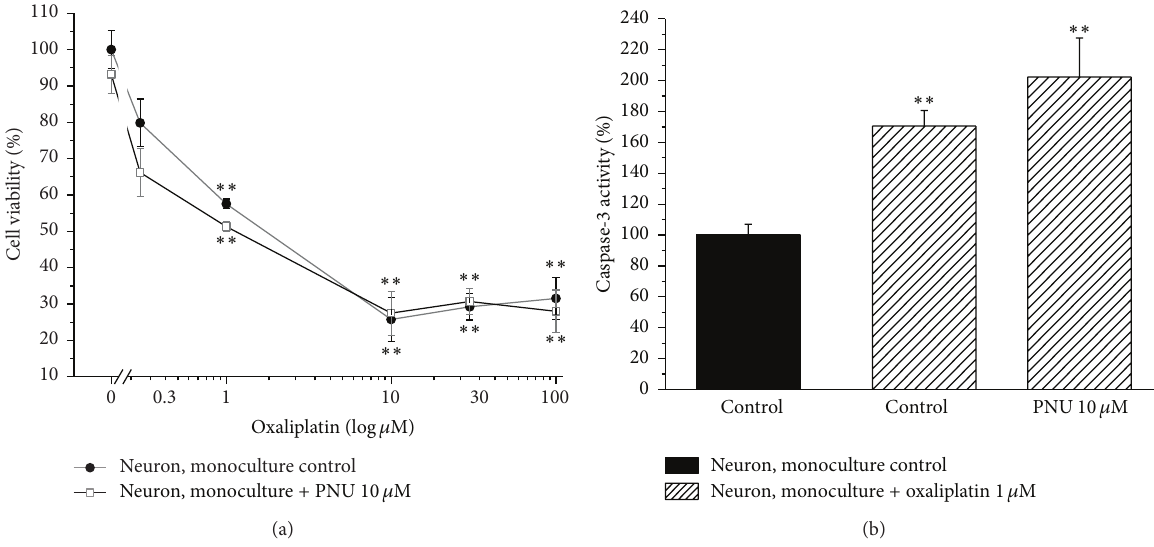
Figure 3: Effect of PNU in neuron monoculture. (a) Cell viability. Neurons (10 4 cells/well) were incubated with oxaliplatin (0.3–100 𝜇 M) in the absence or presence of 10 𝜇 M PNU for 48h. Viability was quantified by MTT assay. Values are expressed in percentage of control absorbance as mean ± S.E.M. of 6 experiments. Control condition absorbance was fixed to 100%. ∗∗ 𝑃 < 0.01 versus control. (b) Caspase-3 activity. Neurons (7 10 5 cells/well) were incubated with 1 𝜇 M oxaliplatin in the absence or presence of 10 𝜇 M PNU for 48h. The enzymatic activity was measured by a fluorescent assay. Values are expressed as percent of control caspase-3 activity arbitrarily set as 100%. One-way ANOVA was performed followed by a Bonferroni significant difference procedure. Bars represent mean ± S.E.M. of 3 experiments. ∗∗ 𝑃 < 0.01 versus control.